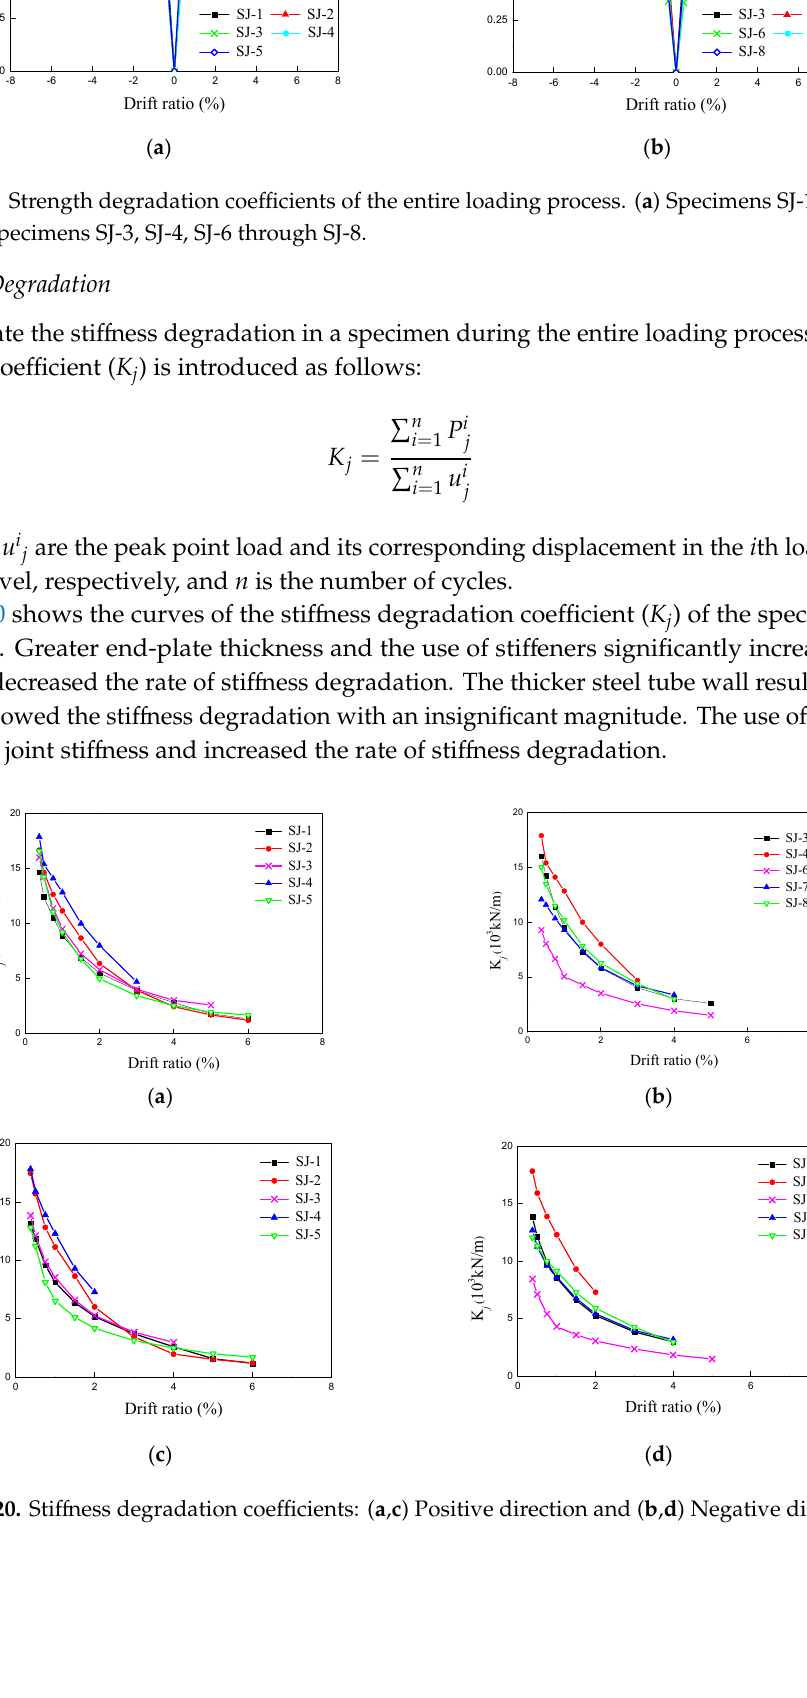
Figure 19. Strength degradation coefficients of the entire loading process. ( a ) Specimens SJ-1 through SJ-5; ( b ) Specimens SJ-3, SJ-4, SJ-6 through SJ-8.